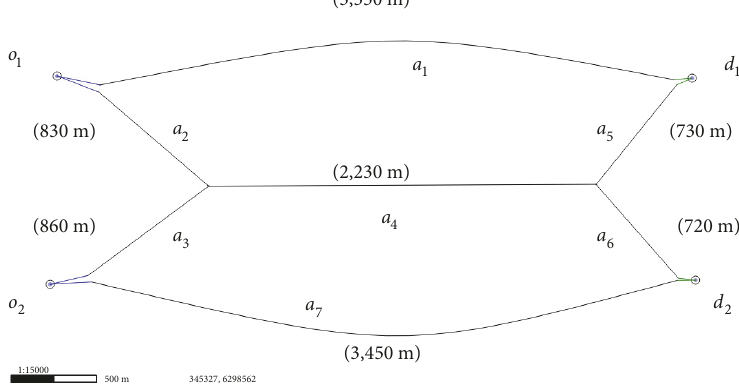
Figure 11: Road Network Microsimulated in Aimsun.